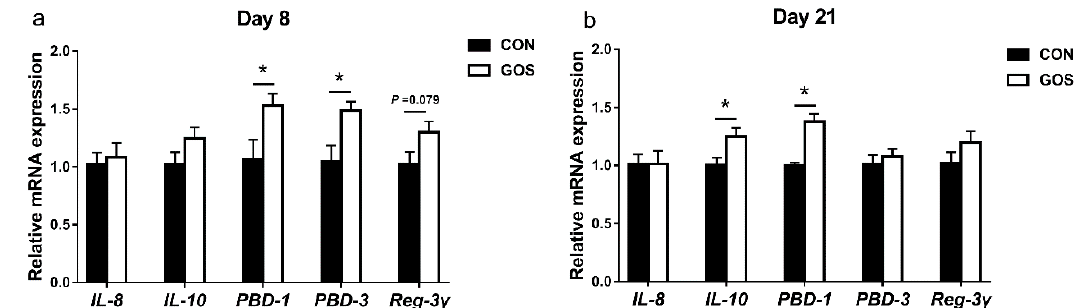
Figure 5. The relative mRNA expression of the ileal inflammatory cytokines and antimicrobial peptides in suckling piglets on day 8 ( a ) and day 21 ( b ). Values are expressed as means ± SEM, n = 6. The “ * ” indicates a significant difference ( P < 0.05) between the CON and GOS group. CON, a control group; GOS, a galacto-oligosaccharides intervention group.